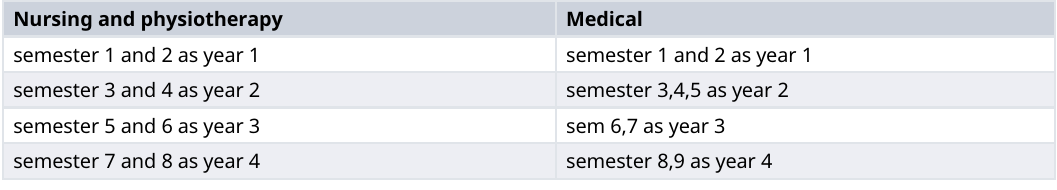
Table 2. The division of semesters into years to have uniformity and homogeneity in statistical analysis. In medical, there are 9 semesters over 4 and half years, therefore, we grouped 3,4, and 5 semesters as year 2 because the same subjects are learned in this period of one and half years.